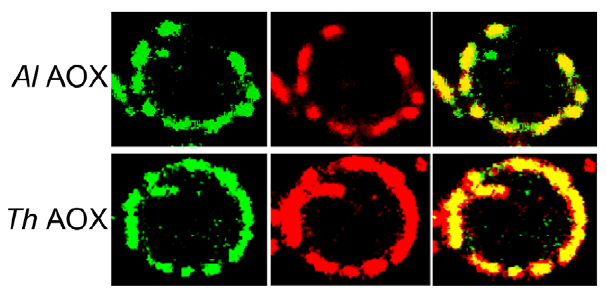
Figure 2. Transfection of S. cerevisiae cells with AOX-GFP constructs. The left panel represents the signal from the GFP-AOX constructs, the centre image represents the mitotracker signal accumulated in the yeast mitochondria. The right panel shows the composite image of the GFP and the red mitotracker signal. The top set (ThAOX) represents the T. hominis AOX-GFP construct, the lower set (AlAOX) represents the A. locustae AOX-GFP construct. In each set of panels a single yeast cell is shown with the branched mitochondrial network around the periphery of the cell that has an approximate diameter of 6 m